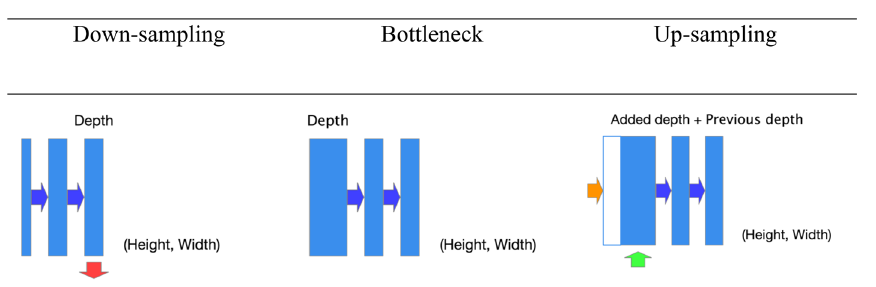
Figure 3. Visual block description. blue arrow stands for convolution layer operation, red arrow stands for Max pooling operation, green arrow stands for up-sampling with zero padding and blue boxes describe the size of the feature